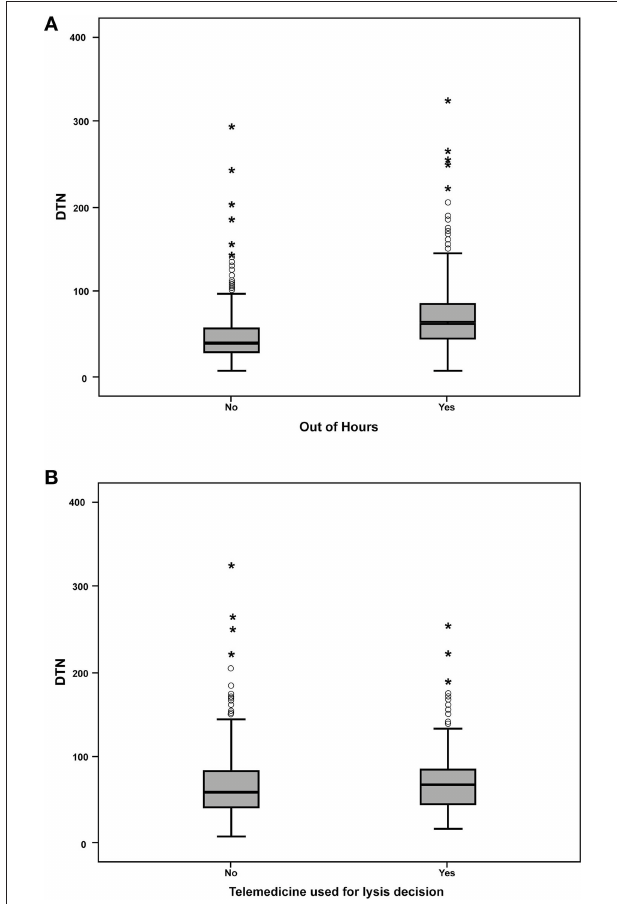
FIGURE 2 | Box-whisker plots. (A) Door-to-needle times for acute ischemic stroke patients treated with intravenous thrombolysis in hours (09:00–17:00) compared with patients treated out of hours. (B) Comparison of out of hours door-to-needle times with and without telemedicine.